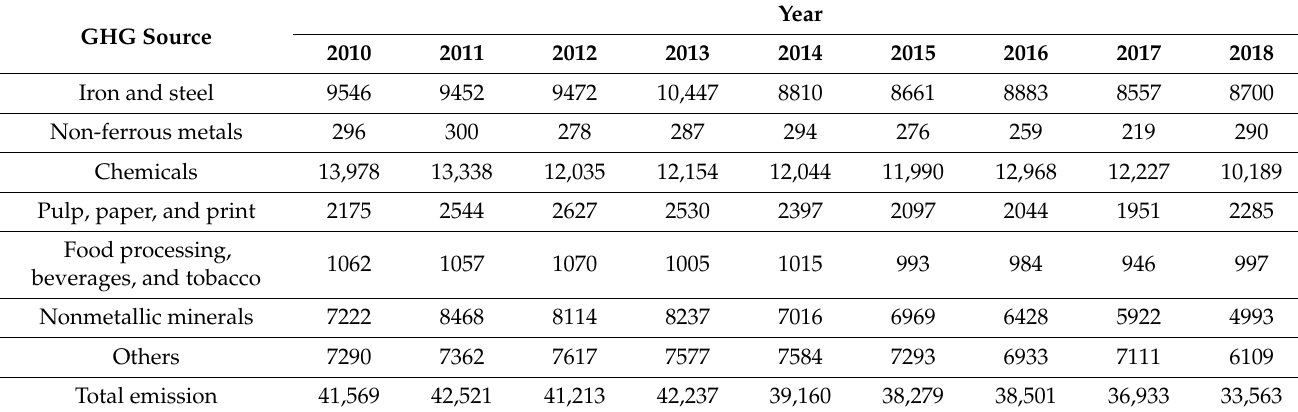
Figure 4. Variations in Taiwan’s GHG emissions from the manufacturing and construction industries during the period of 2010–2018 [18]. Table 4. Taiwan’s GHG emissions from the manufacturing and construction industries in terms of GHG sources since 2010 1 .